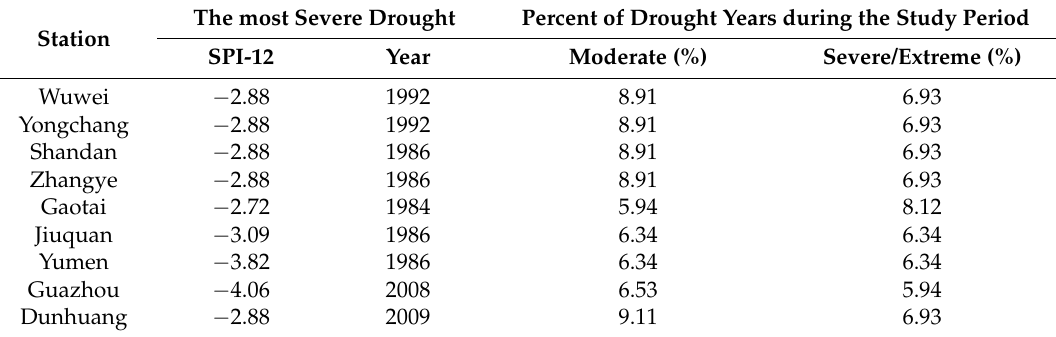
Table 9. Drought characteristics at a 12-month scale in the study